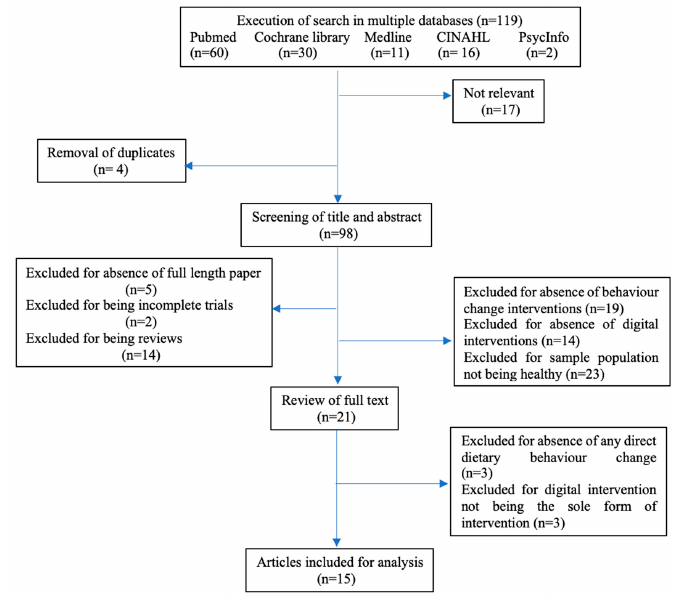
Figure 1. Flow diagram showing the Preferred Reporting Items for Systematic Reviews and Meta-Analyses (PRISMA) strategy used to search the literature. Table 1. Characteristics of the articles selected for analysis.